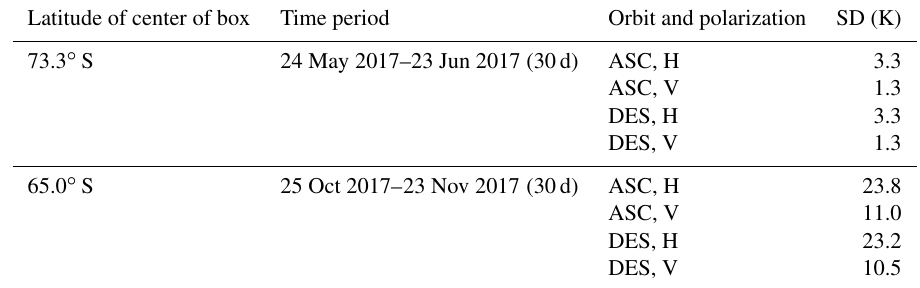
Table 5. Standard deviation of T B images in two subregions along the Ross Sea buoy trajectory. Times correspond to the buoy within each box. Satellite orbits and polarizations are ASC horizontal (ASC, H), ASC vertical (ASC, V), DES horizontal (DES, H), and DES vertical (DES,